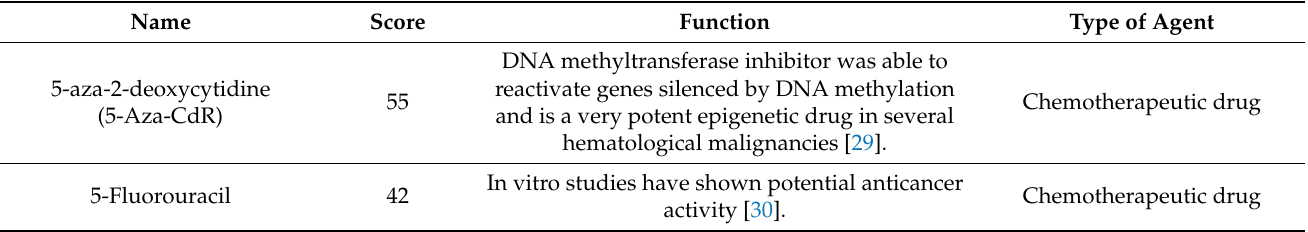
Figure 5. Structural network of drugs and their targeted miRNAs generated with miRNAs and their targets involved in AIS. This network addresses chemical compounds, such as drugs or xenobiotics, among others (shown as yellow nodes), associated with our miRNA dataset (green nodes) within the mirNET database (https://www.mirnet.ca/upload/MirUploadView.xhtml 29 December 2021). For a better image resolution, please review the Supplementary Materials (Figure S5). Table 1. The most outstanding repositioned drugs lead to miRNAs involved in AIS from the pharmacology network analysis (the score is depicted as a node with more neighbors).